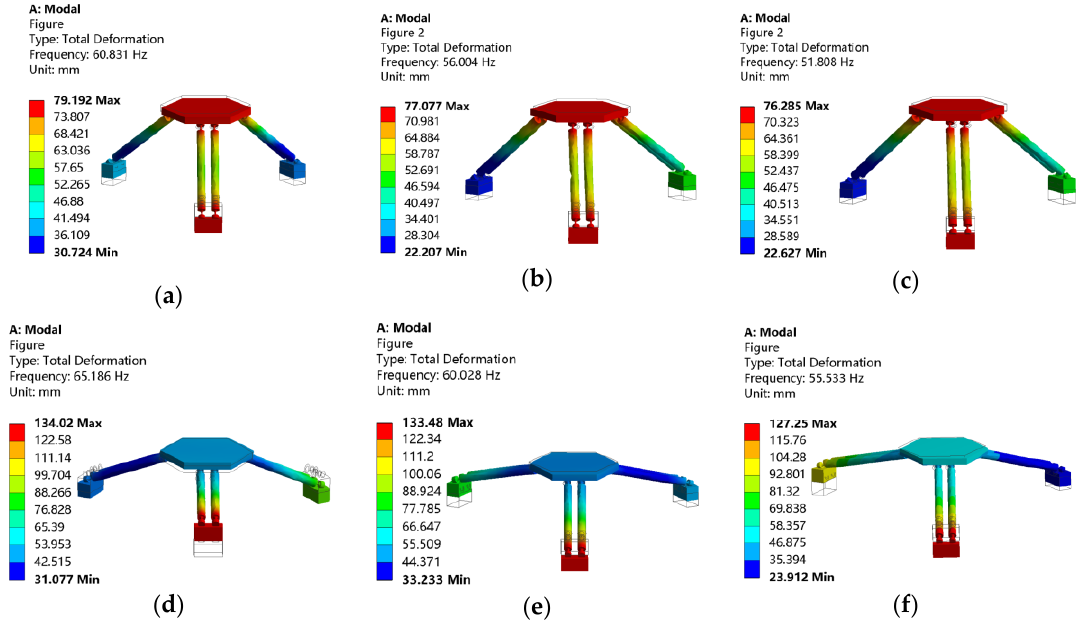
Figure 10. Modal analysis of models with different length l and angle θ l . ( a ) l = 65 mm, θ l =45 ◦ . ( b ) l = 70 mm, θ l =45 ◦ . ( c ) l = 75 mm, θ l =45 ◦ . ( d ) l = 65 mm, θ l =70 ◦ . ( e ) l = 70 mm, θ l =70 ◦ . ( f ) l = 75 mm, θ l = 70 ◦ .